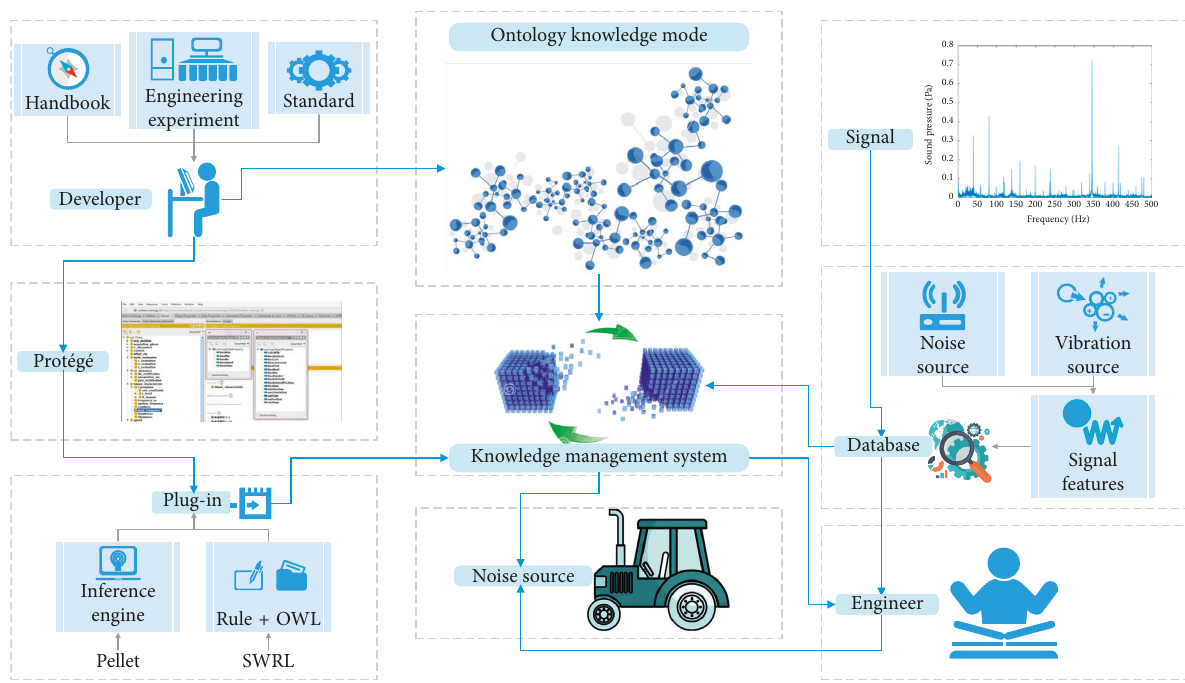
Figure 2: Prototype framework.